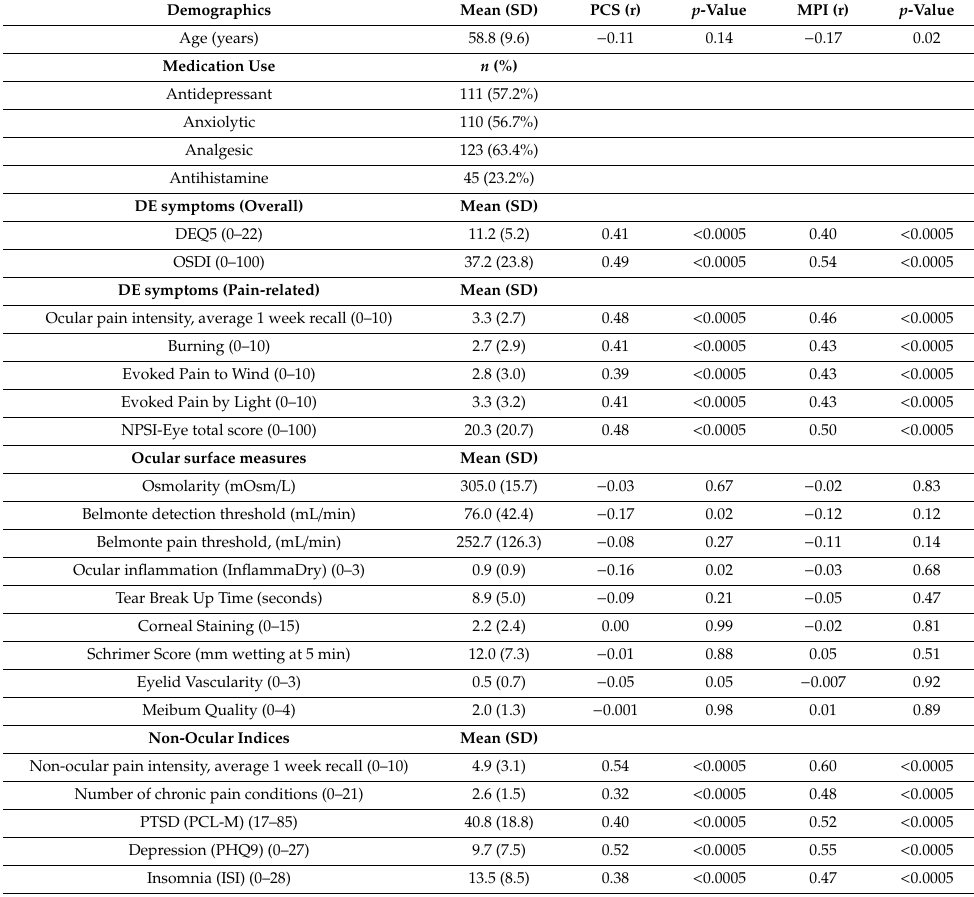
Table 1. Clinical Characteristics of the Population and Relationships to Catastrophizing (PCS) and Pain-Related Interference